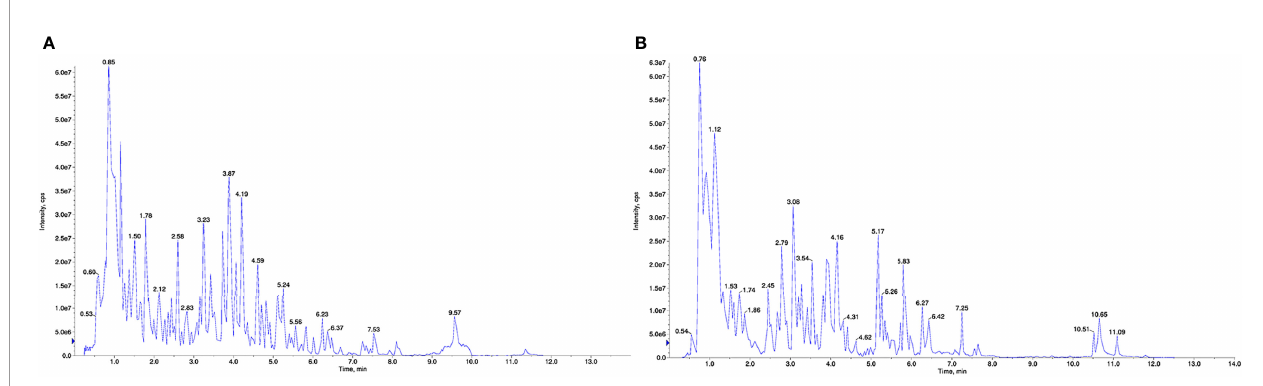
FIGURE 1 | UPLC – ESI – MS/MS total ion chromatogram of BHD. (A) Positive ion mode. (B) Negative ion